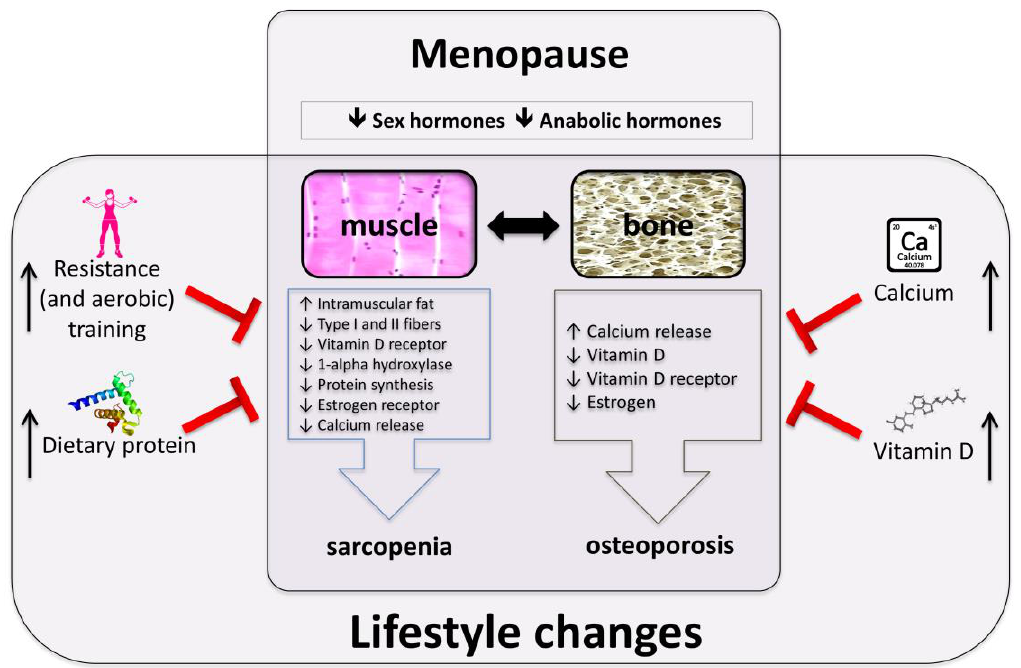
Figure 1. Menopause-related factors affecting muscle and bone and their possible prevention through a rationale strategy based on protein and vitamin D supplementation regimens in combination with specifically-designed training protocols.